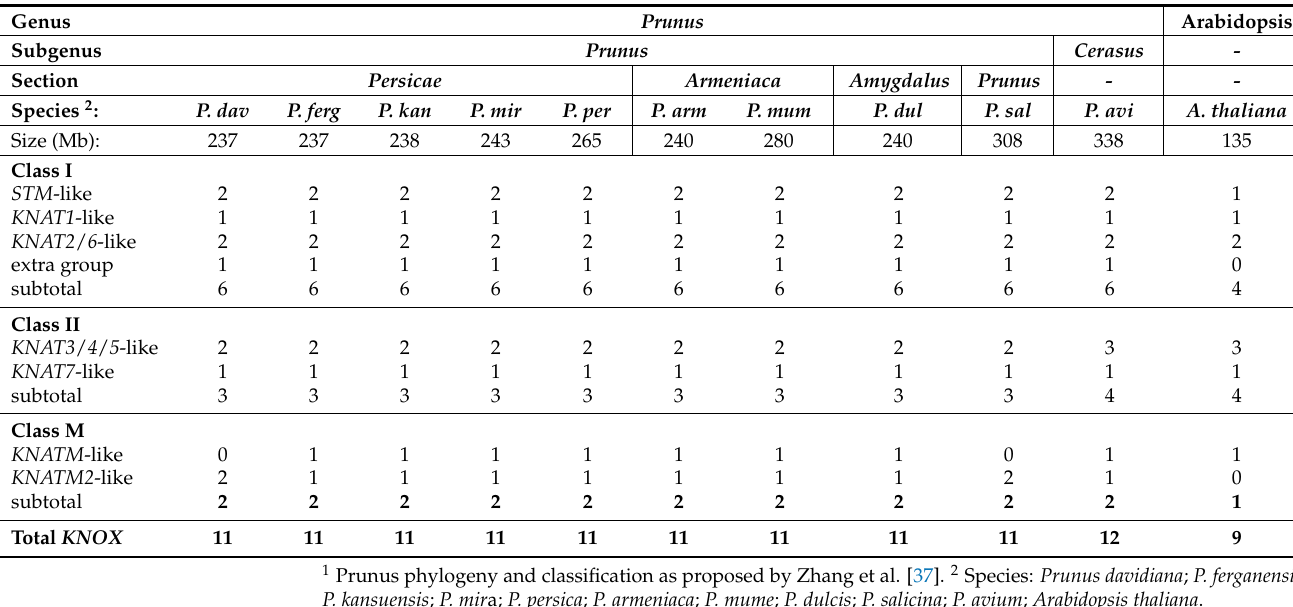
Table 1. Summary of KNOX gene members across ten diploid Prunus spp. 1 .